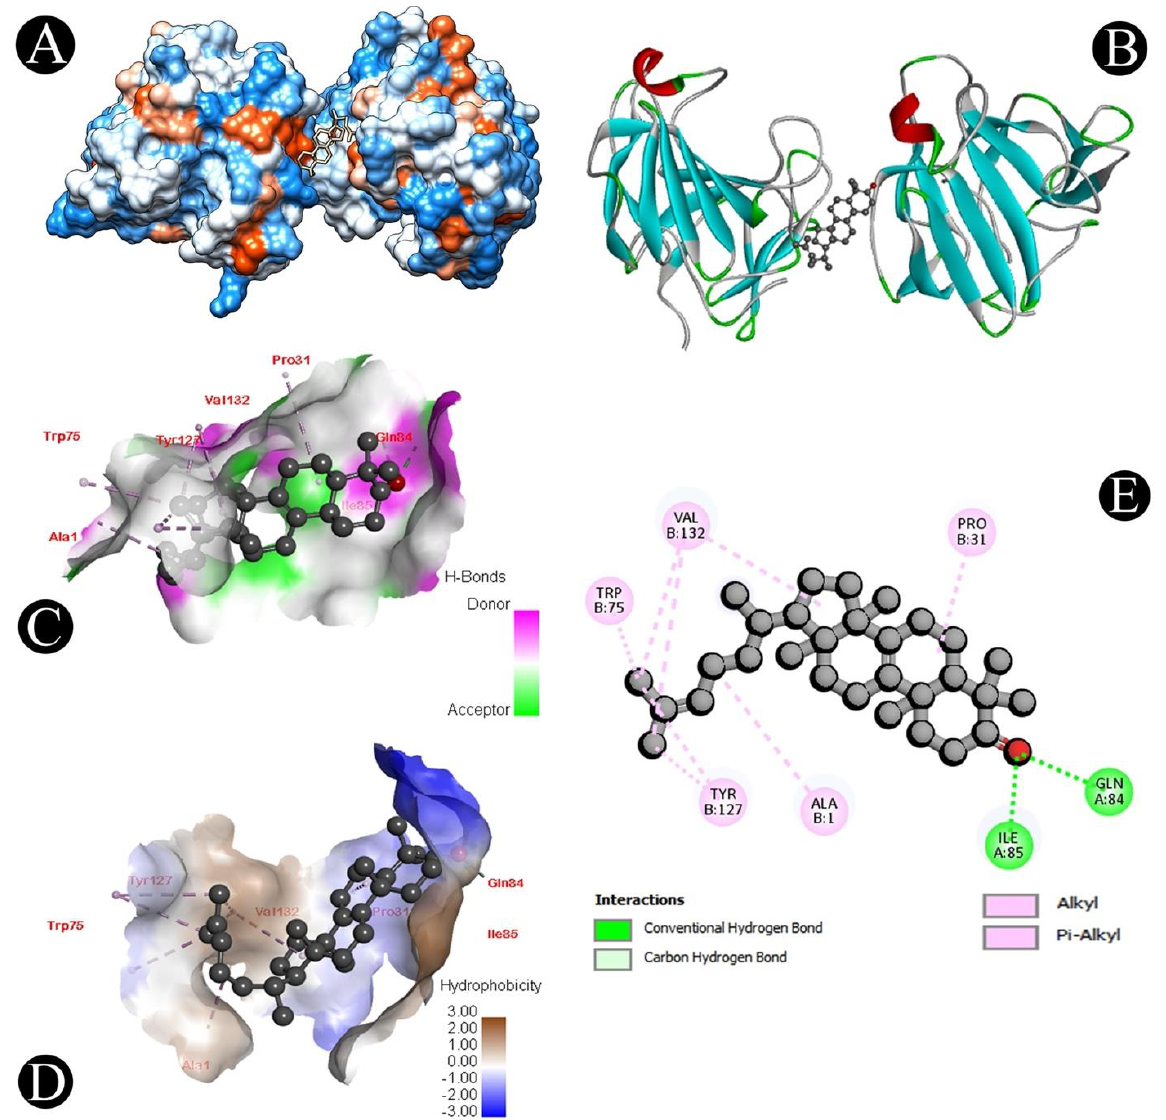
Figure 9. Visualization of the docking analysis of 1H-indene,1-hexadecyl-2,3-dihydro binding with 3IT7. ( A ) Hydrophobicity surface 3D representation. ( B ) Interaction of 1H-indene,1-hexadecyl-2,3-dihydro with 3IT7. ( C ) Visualization of hydrogen bond. ( D ) Visualization of hydrophobic interaction. ( E ) Two-dimensional representation describing the bindings of 1H-indene,1-hexadecyl-2,3-dihydro with an active site of 3IT7.